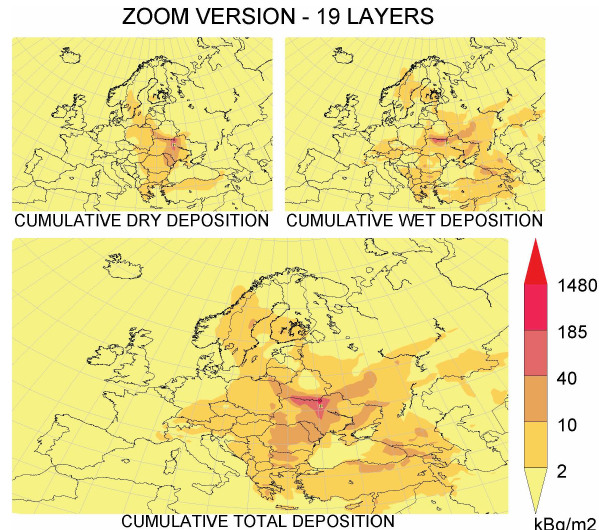
Fig. 13. Cumulative dry, wet and total deposition of 137 Cs (kBqm − 2 ) from the day of the accident (26 April 1986) until the end of 1986. Results of the simulation using the regular grid of the model for 39 vertical layers and accounting for the altitude of the emissions with respect to Table 1 (RG39L).